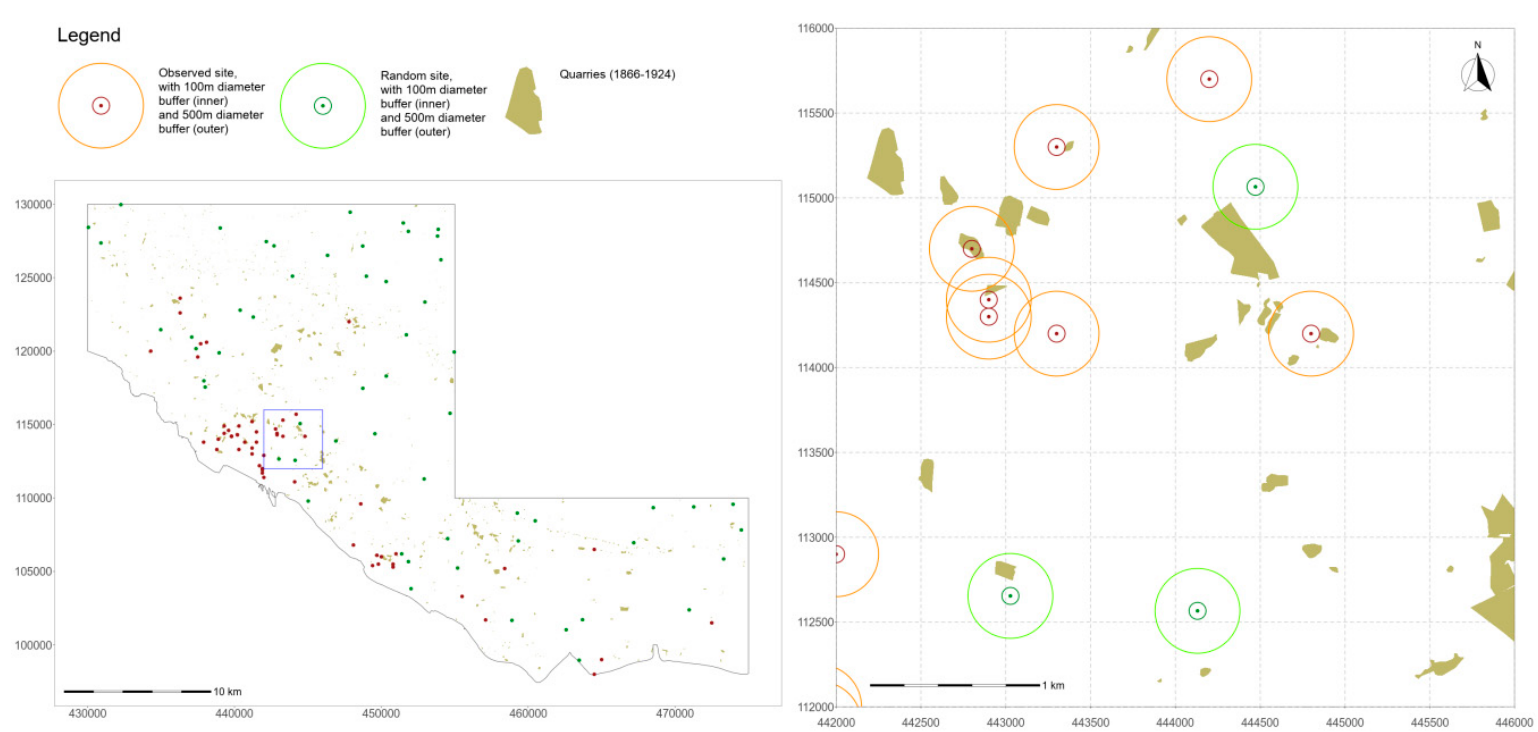
Figure 2. Observed sites, random sites and uncertainty buffers. Inner (100 m diameter) buffers were used in this analysis. The greater the uncertainty, the larger the buffer, and hence, the higher the probability of intersection between sites and quarries.